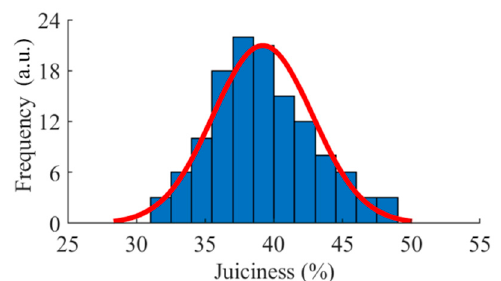
Figure 4. The juiciness distribution of all pears during storage. a.u. stands for arbitrary unit. Table 1. Juiciness statistics of the calibration set and external verification set. Sets Number of the Samples Juiciness (%) Maximum Minimum Average Calibration set 100 48.5 External verification set 27 47.9 32.2 39.1